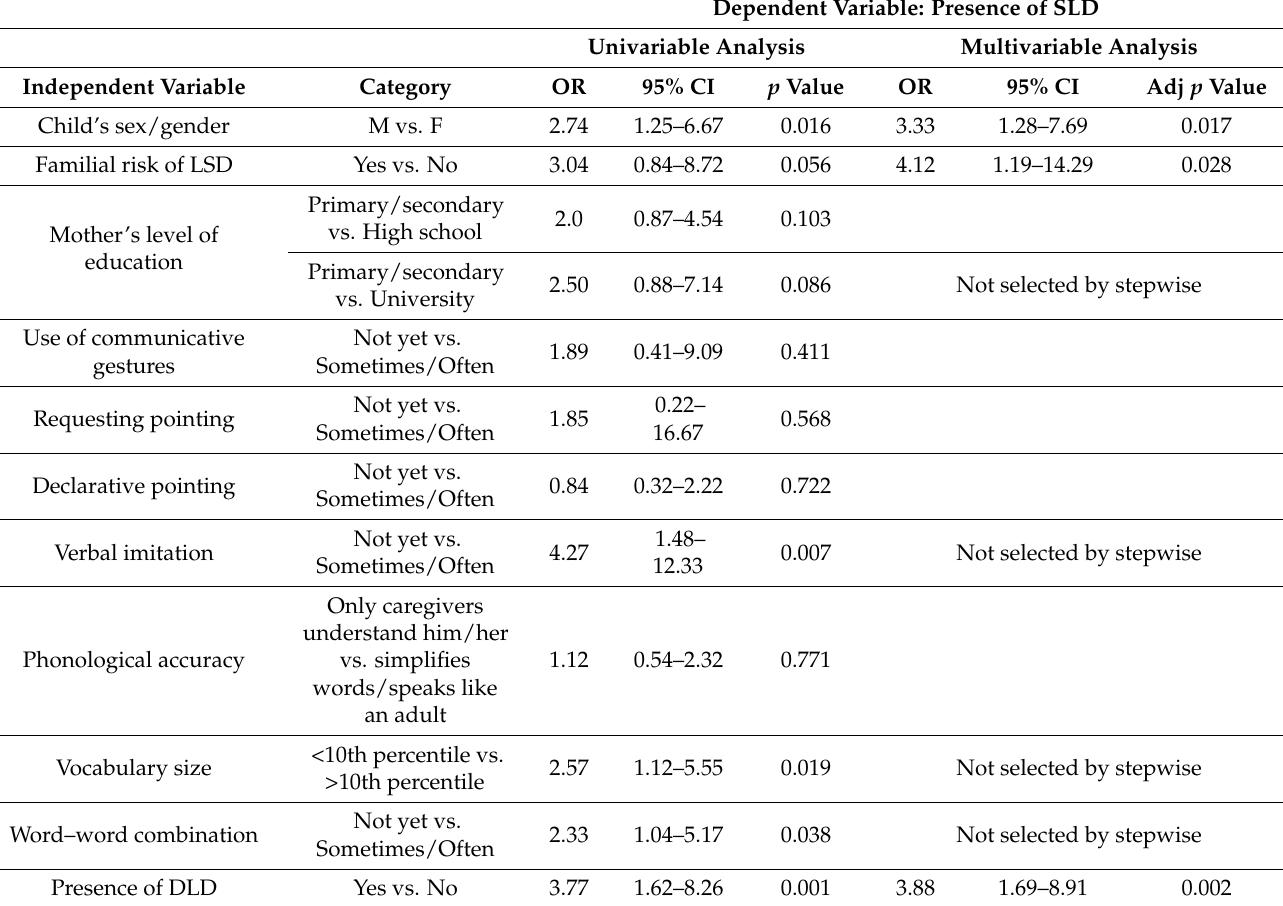
Table 3. Details of the univariable analyses and of the best multivariable model with diagnosis of SLD as the dependent